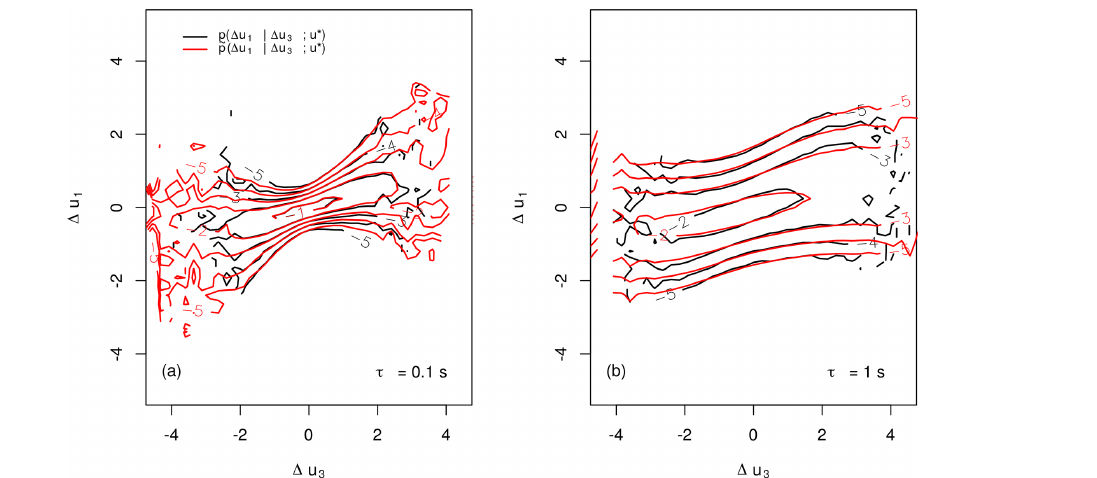
Figure 2. Comparison of the double cpdf’s p ( (cid:49)u 1 | (cid:49)u 3 ; u ∗ ) (estimated from data) and (cid:101) p ( (cid:49)u 1 | (cid:49)u 3 ; u ∗ ) (obtained from CKE) for τ 1 = 0 . 1s (a) or 1s (b) and τ 2 = 2 τ 1 , τ 3 = 3 τ 1 , (cid:49)τ = τ 2 − τ 1 = τ 3 − τ 2 and u ∗ =